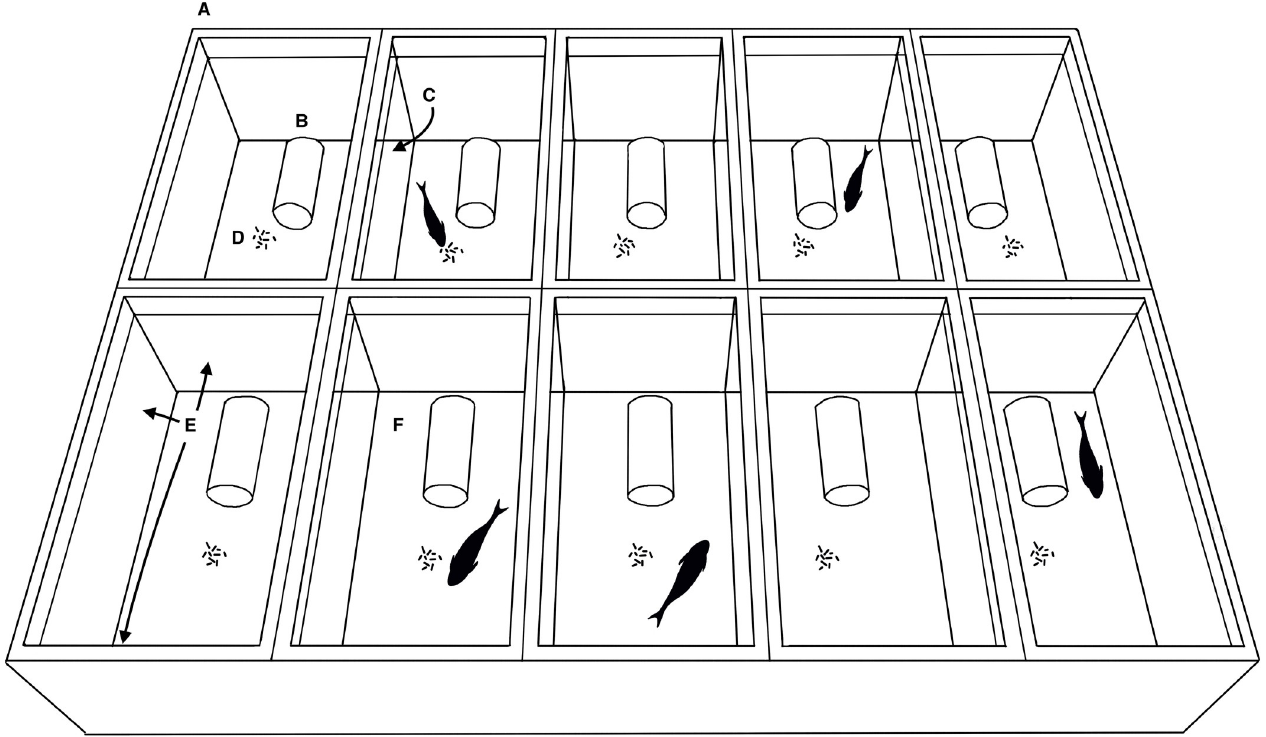
Fig 2. Individual experimental aquaria used for each TAN treatment. A: Schematic representation of a group of 20 L individual aquaria used for each TAN treatment in the experiment with B . meridionalis (aquaria were placed on a solid deck pallet to facilitate handling). B: PVC tube refuge. C: Transparent lateral walls between neighbouring aquaria. D: Red chironomid larvae used to observe feeding behaviour. E: Exterior and frontal walls of the aquaria covered with blue acetate sheets. F: Bottom of aquaria covered by a blue acetate sheet.